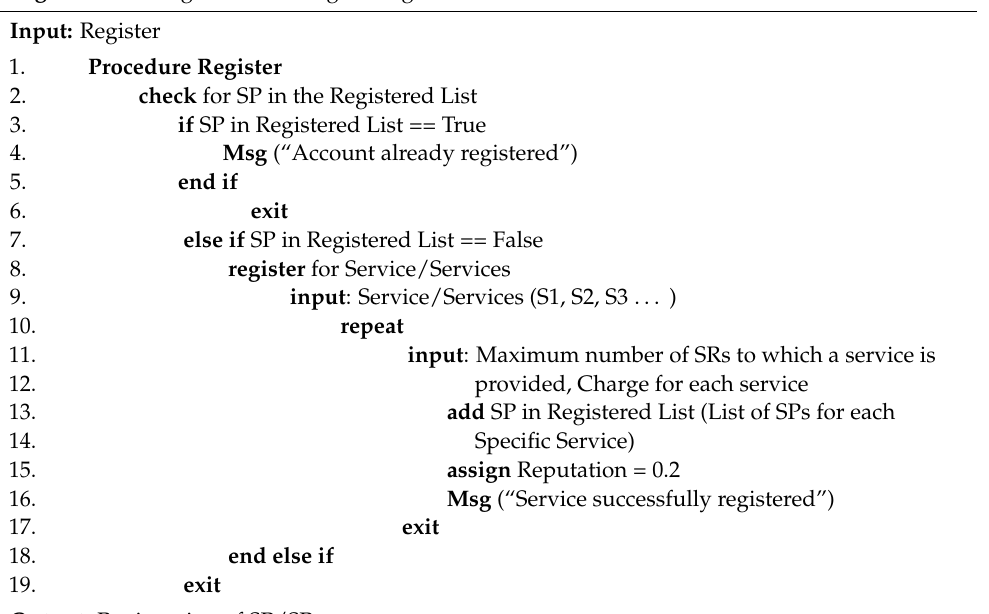
Algorithm A1 Algorithm for Registering Service